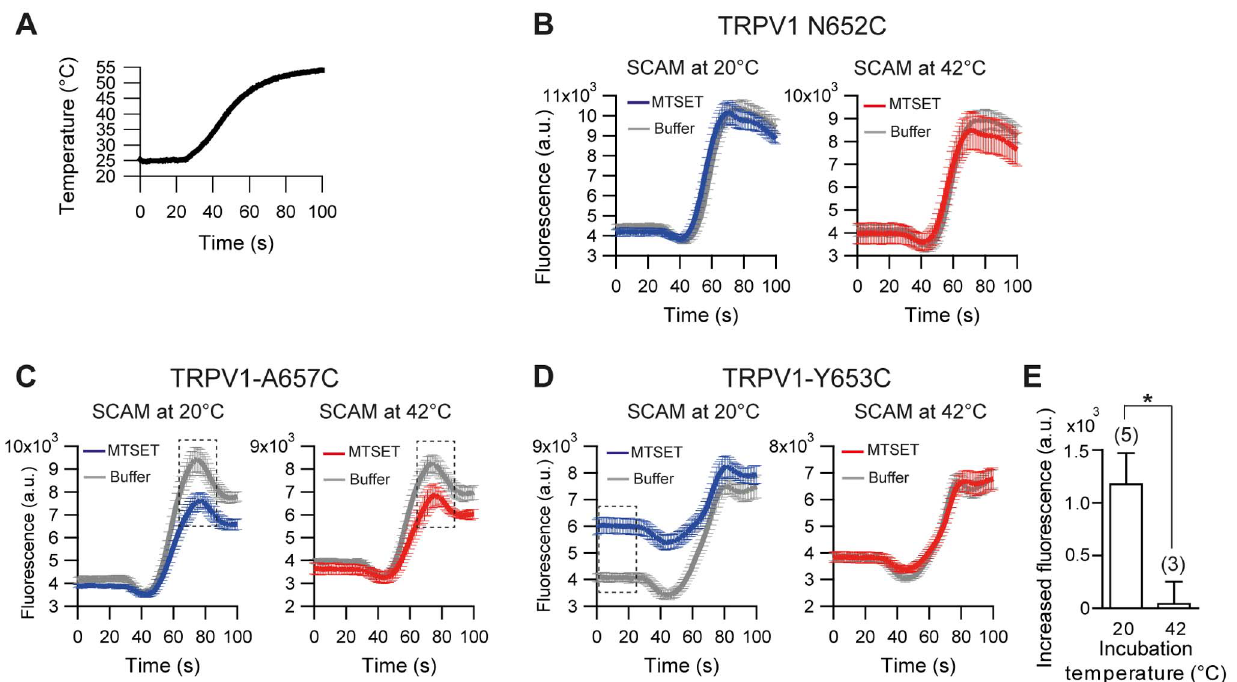
Figure 2. Temperature-dependent labeling in TRPV1. (A) Temperature as a function of time during FLIPR temperature-activation assay. (B–D) Representative examples of fluorescence responses upon temperature stimulation of TRPV1 N652C (B), A657C (C) and Y53C (D) after incubation of MTSET at 20 u C (blue) and 42 u C (red). For both temperatures, buffer as a negative control is colored gray; n . 8 wells. Error bars are 2 6 s.e. (E) Average basal fluorescence change of TRPV1 Y653C after incubation of MTSET at 20 u C and 42 u C. The basal fluorescence is averaged fluorescence level between 0 to 20 sec. For each experiment, the increase of basal fluorescence was obtained by subtracting buffer control from MTSET incubation. Five independent experiments were performed for 20 u C and three for 40 u C with n . 5 wells per experiment. Two-tailed t-test, *p=0.036. Error bars are mean 6 s.e.